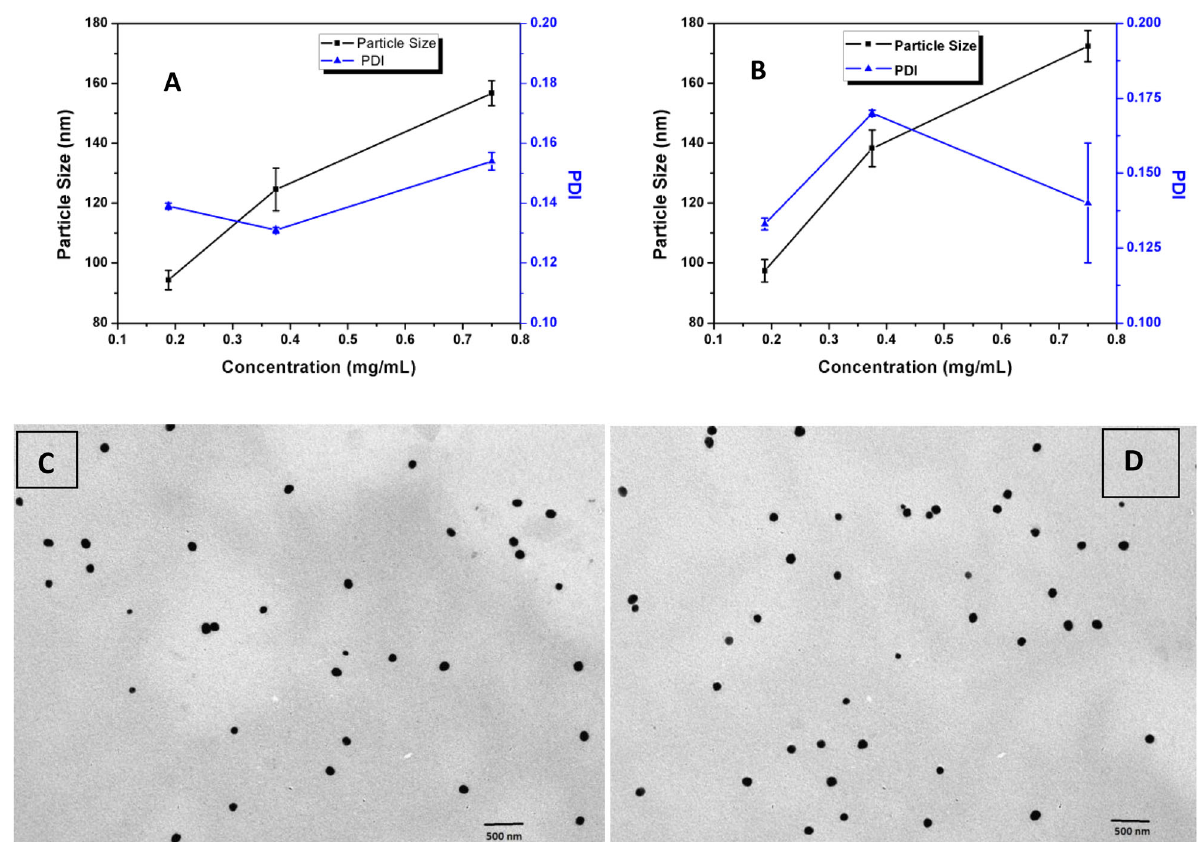
Fig. 3 Size and PDI values. A PLGA55-coumarin-6, B PLGA72-coumarin-6 particles with varying polymer concentrations in the organic phase. C , D TEM images of PLGA55-coumarin-6